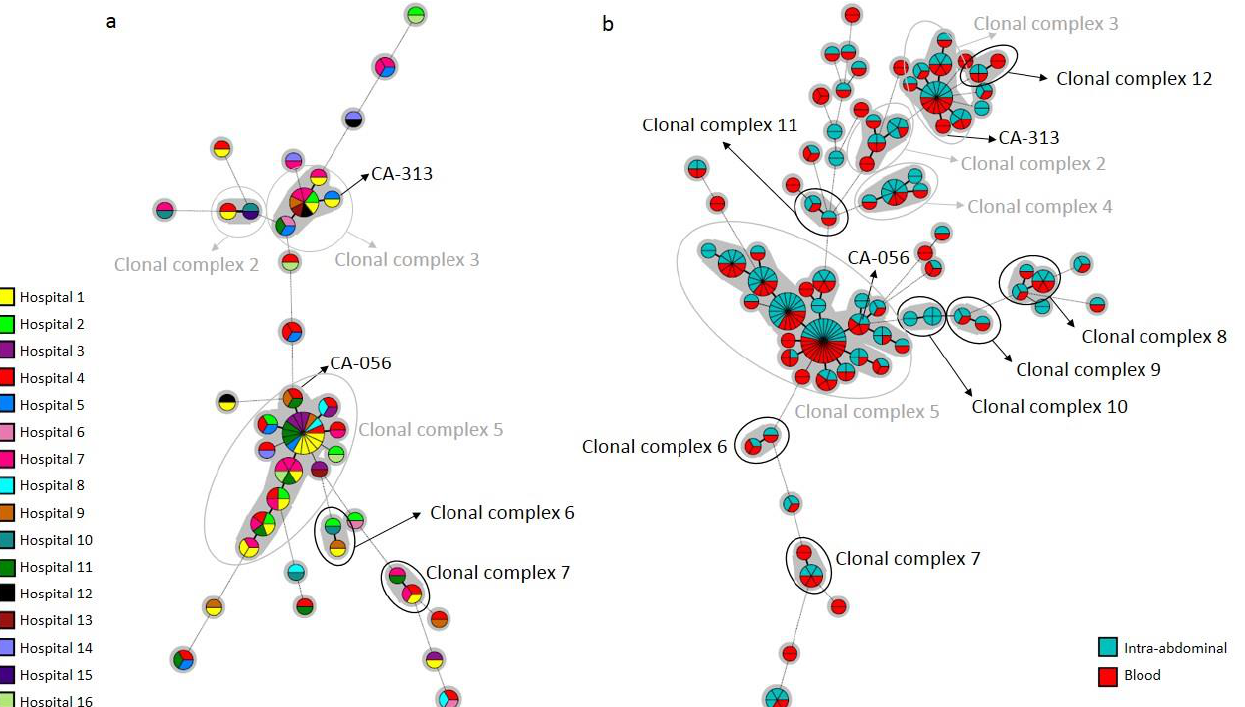
Figure 3. Minimum spanning tree showing widespread C. albicans clusters found in blood cultures shown per hospital of source ( a ) or combined with intra-abdominal samples ( b ). Circles represent different genotypes and circle size the number of isolates belonging to the same genotype. Connecting lines between circles show profile similarities. The solid bold line indicates differences in only 1 marker, solid line indicates differences in 2 markers, dashed line indicates differences in 3 markers, and dotted line indicates differences in 4 or more markers. CA-056 and CA-313 were resistant genotypes. Grey circles depict previously reported clonal complexes 2 to 5. Black circles depict clonal complex 6–12, newly reported